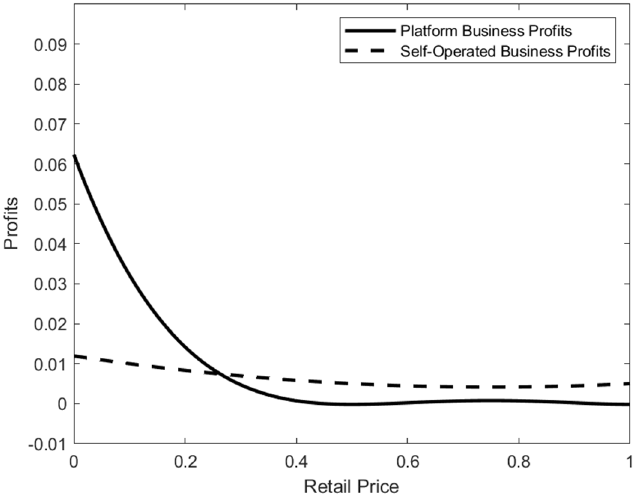
Figure 12. Self-operated business profits and platform business profits in the complementary case.